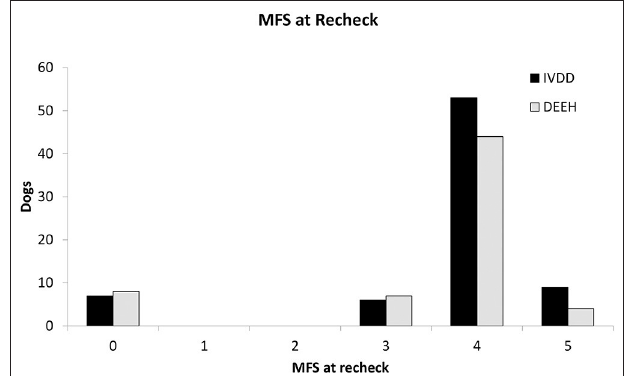
for dogs with DEEH compression (4) without a control